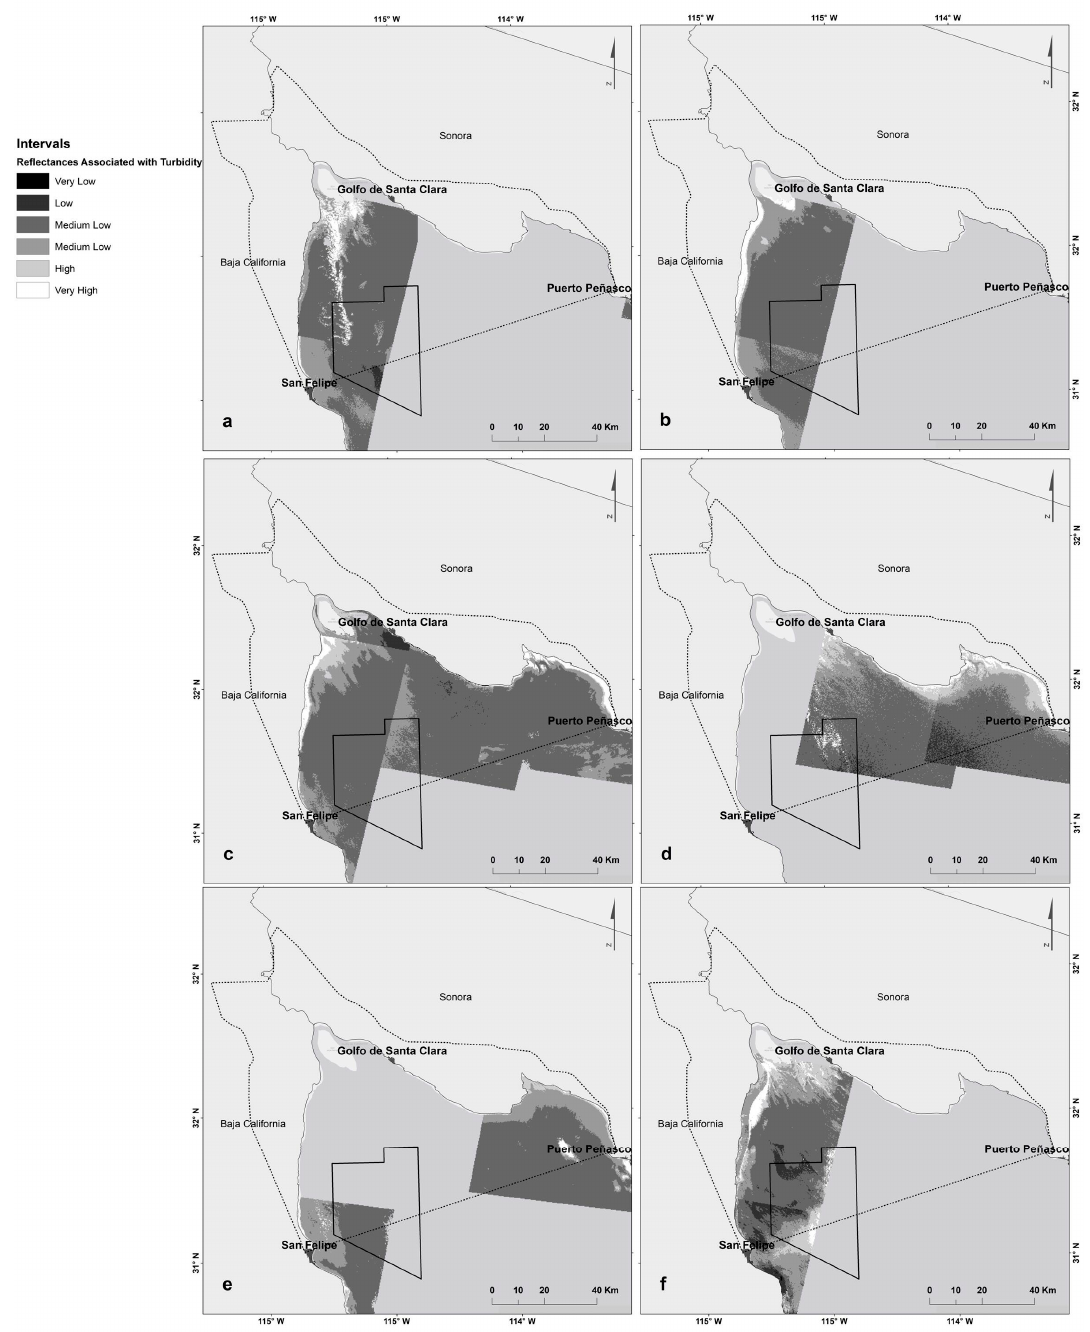
Figure 3. UGC maps of turbidity for the year 2011 in ( a ) cold season, spring tide in flow; ( b ) cold season, neap tide in ebb flow; ( c ) cold season, neap tide in flow; ( d ) warm season, neap tide in flow; ( e ) warm season, neap tide in ebb flow and ( f ) warm season, spring tide in flow. The Biosphere Reserve area and the Vaquita marina refuge polygons are